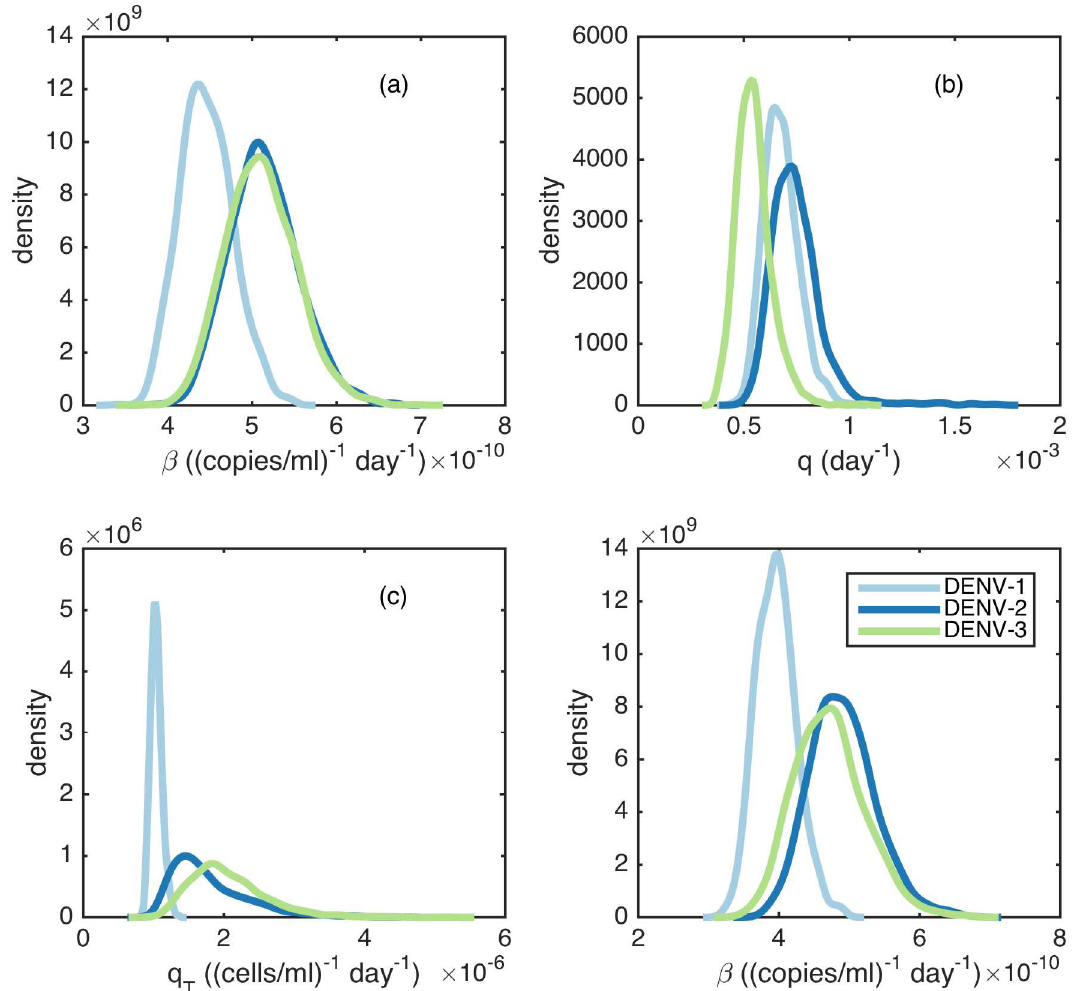
Fig 5. Parameter estimates from the serotype-specific models. (a) Density estimates for serotype-specific viral infectivity rates β for model SS β . (b) Density estimates for serotype-specific innate immune response activation rates for model SS q . (c) Density estimates for serotype-specific T-cell activation rates q T for model SS serotype-specific viral infectivity rates β for model SS β that was fitted to only the subset of the viral load data with individualswith a detected viral peak. The median parameter estimate and 95% posterior credible interval (in parentheses) of the difference of the parameter estimates shown in (a-d) relative to DENV-1 are: (a) β 2 − β 1 : 6.6 × 10 − 11 (3.6 × 10 − 11 , 1.1 × 10 − 10 ),